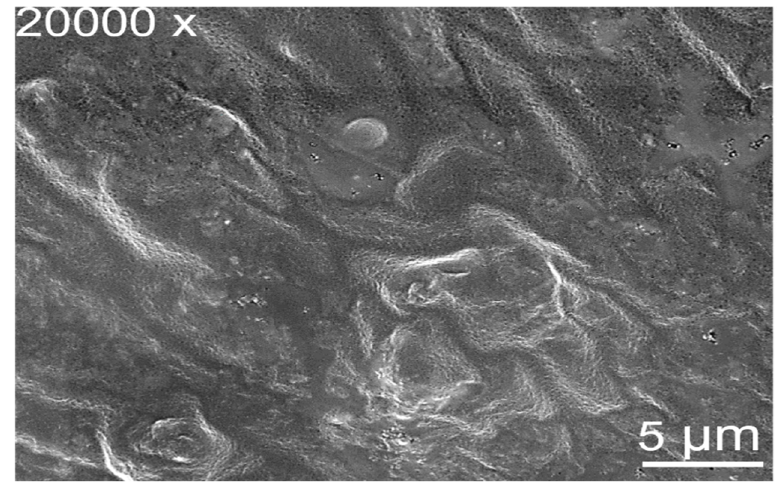
Figure 6. Morphological characteristics of Azadirachta indica oil nanohydrogels analyzed by Scanning electron microscope (20,000× magnification).